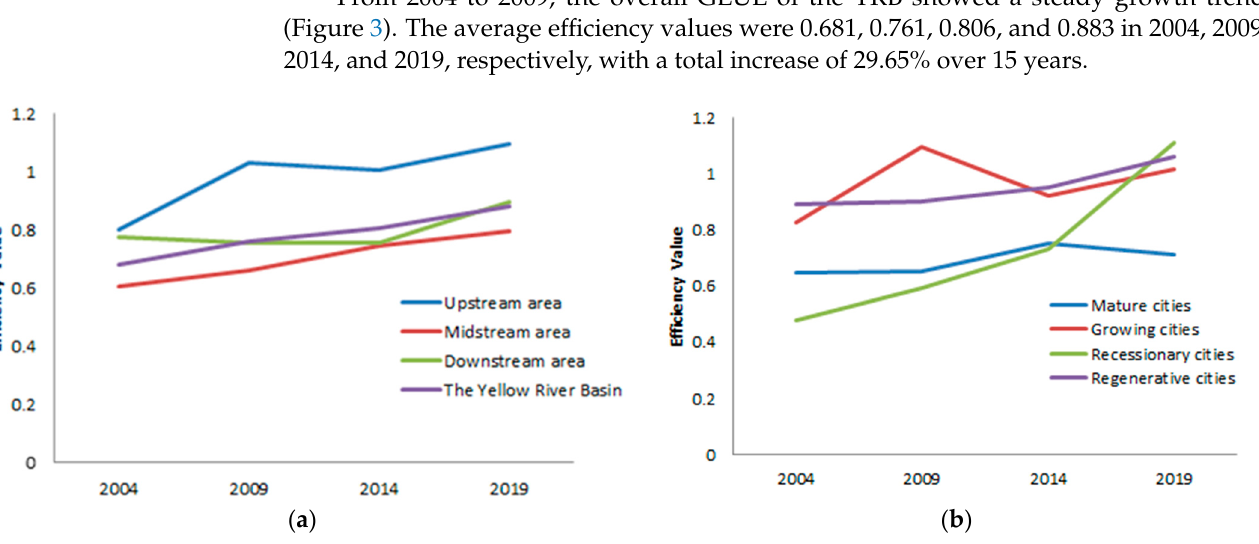
Table 3. Index system of influencing factors of GLUE in resource-based cities.